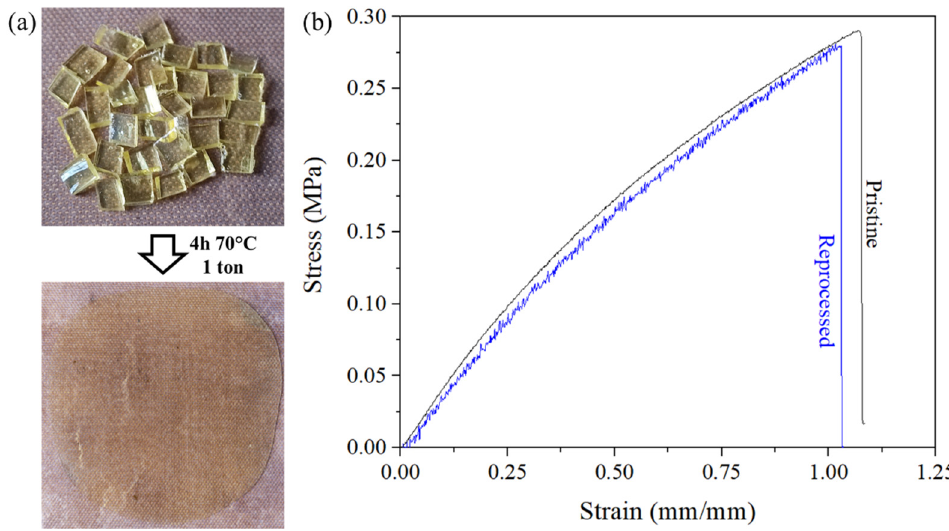
Figure 8. ( a ) Digital images of H50 film before and after reprocessing by hot pressing 4 h at 75 °C, ( b ) stress-strain results of pristine and reprocessed H50 samples.